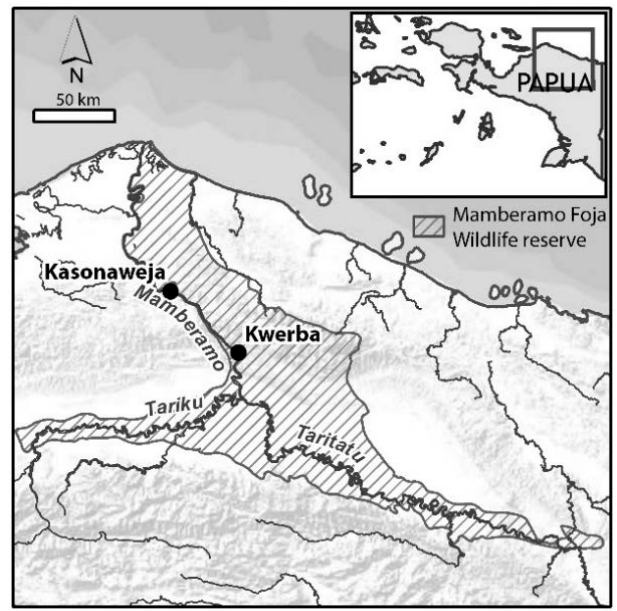
Figure 1. Location of the study area in